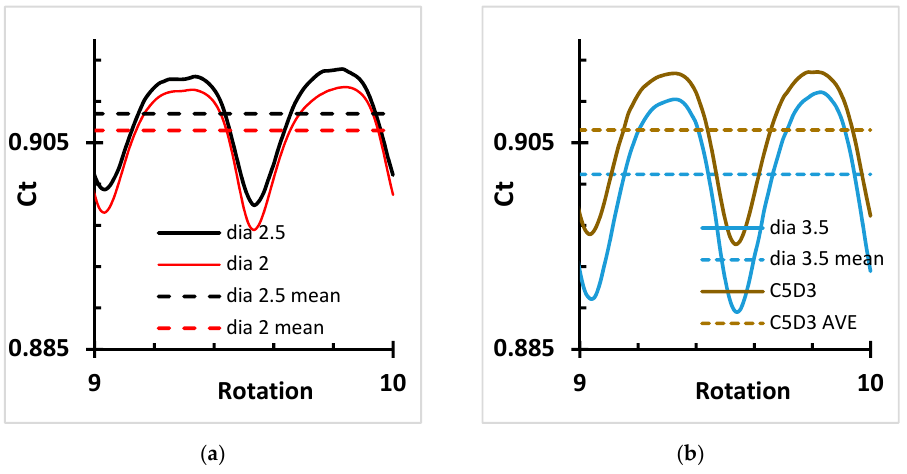
Figure 6. Coefficient of thrust for tower having diameter ( a ) 2 and 2.5 m ( b ) 3 and 3.5 m.